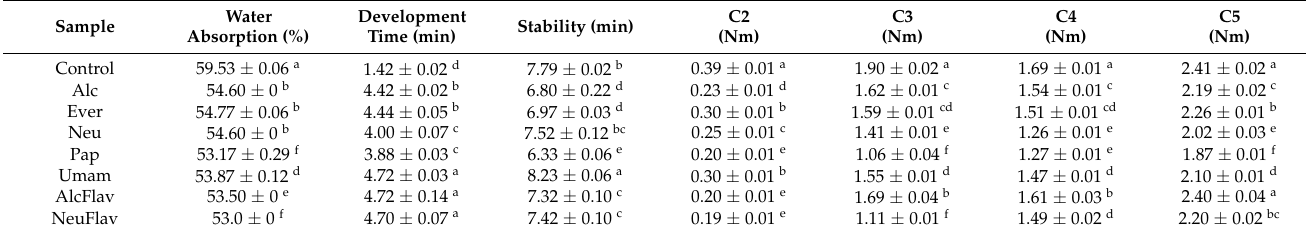
Table 3. Rheological characterization of dough with added soy protein hydrolysates obtained with different proteases assessed by